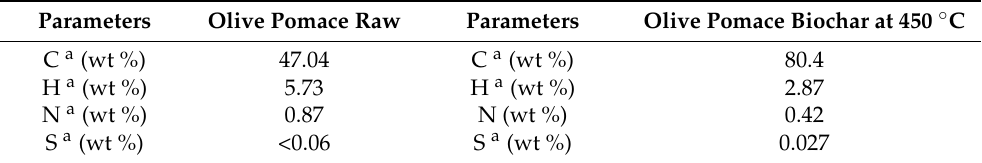
Table 1. Ultimate analysis of raw olive pomace and olive pomace biochar (adapted from [38]). Parameters Olive Pomace Raw